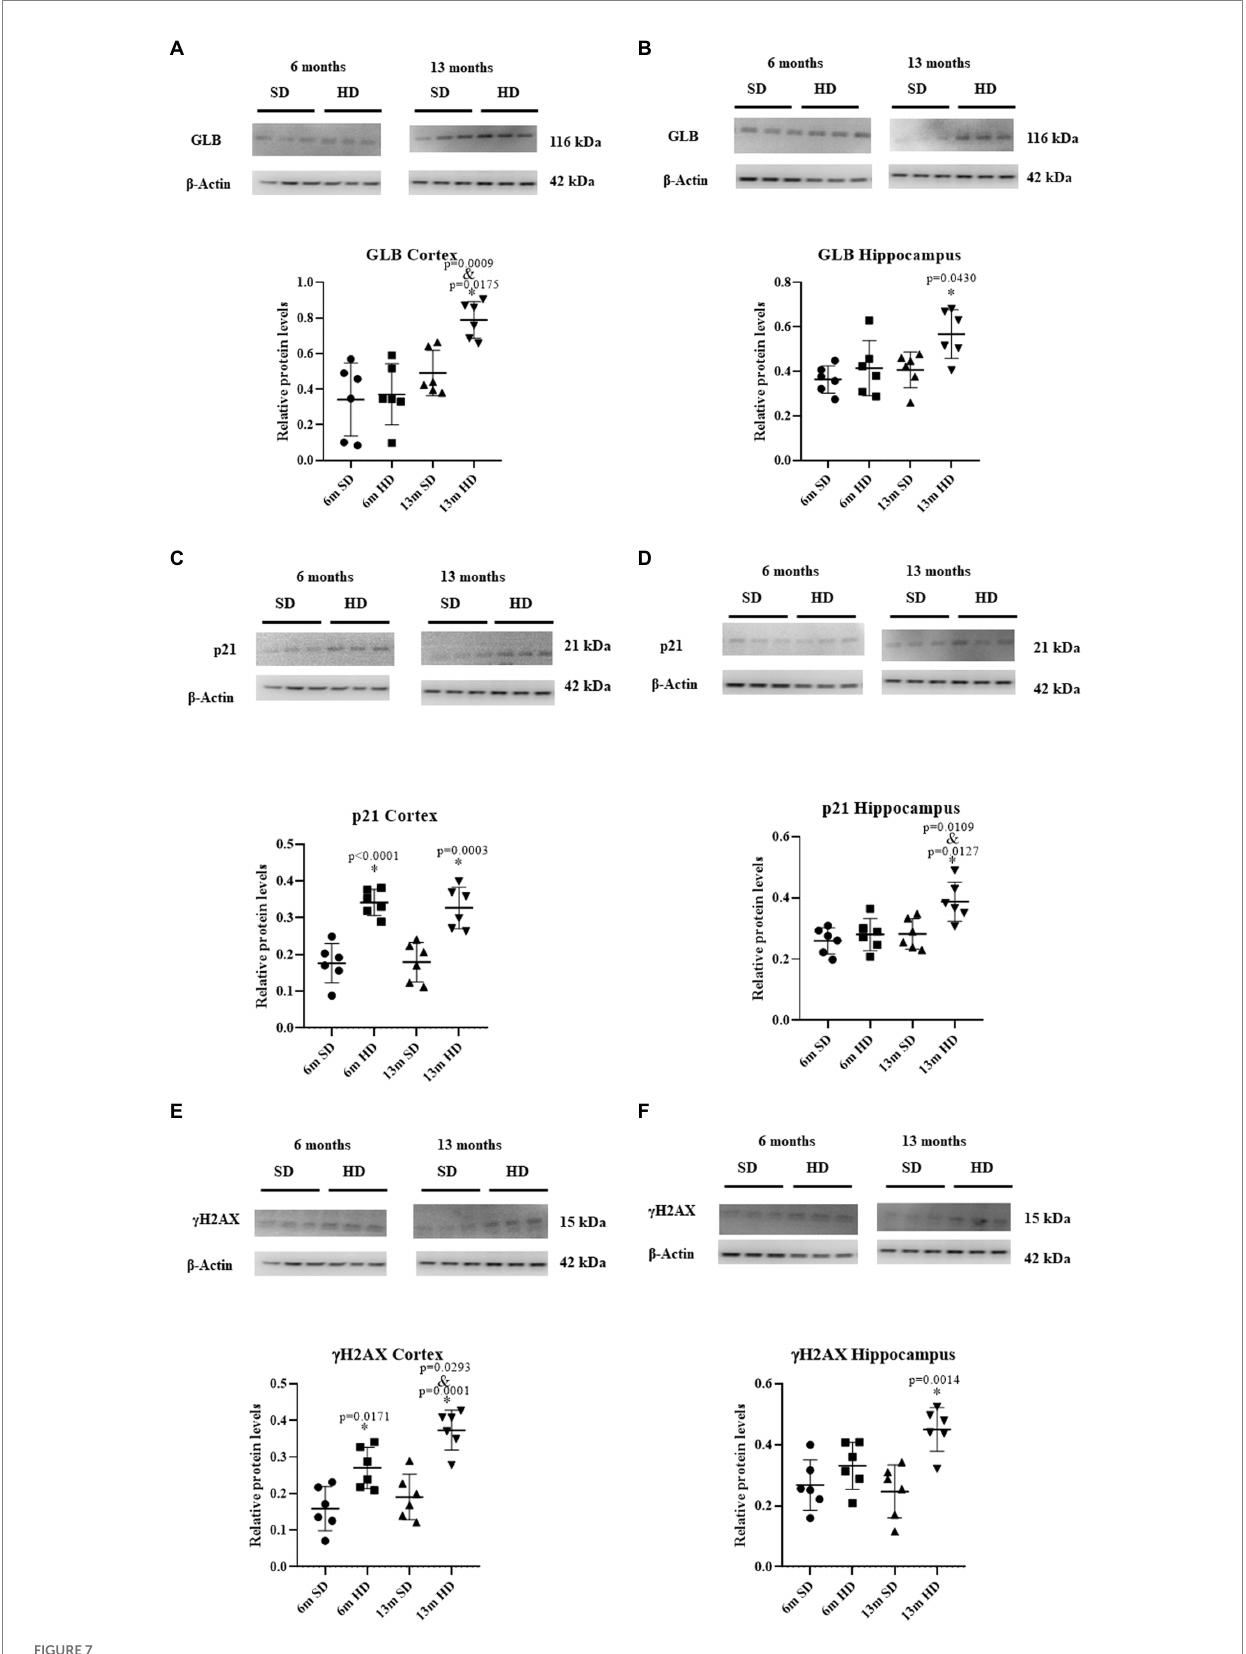
FIGURE 7 Expression of molecular markers of senescence in brain. Representative Western blot analysis of GLB in the Cx (A) and Hc (B) ; p21 in the Cx (C) and Hc (D) ; and γ H2AX in the Cx (E) and Hc (F) . The graphs show the densitometric protein expression analysis from six animals per age group (each dot represents an animal; n = 6 SD and n = 6 HD). The data represent the mean ± SD, the data were compared using the two-way ANOVA and Tukey’s post hoc test. The significant differences between groups compared to the SD are marked with *, and differences at different ages are marked with & p <